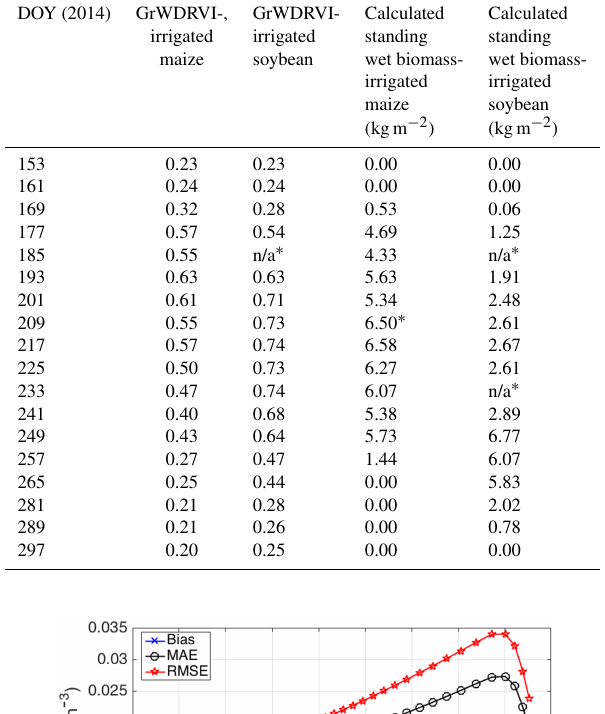
Table 3. Summary of 2014 GrWDRVI and calculated standing wet biomass for irrigated maize and irrigated soybean fields near Waco, NE. Note that the senescence equation was applied to DOY 209 for the irrigated maize field as planting date and development can vary locally. The drop in GrWDRVI between DOY 201 and 209 is a clear indicator of change in plant growth stage that can be used on a field- by-field basis. ∗ Note that n/a stands for not applicable because of a lack of data.